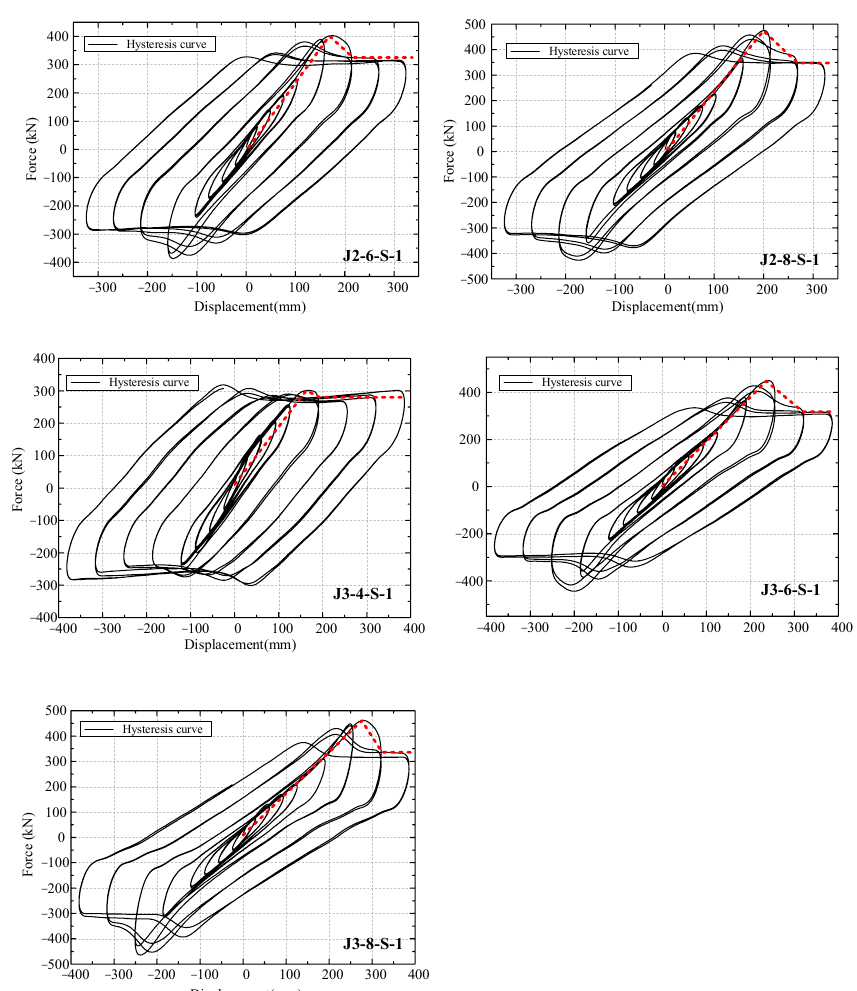
Figure 8. Force-displacement curves of LRBs at steel friction interface.